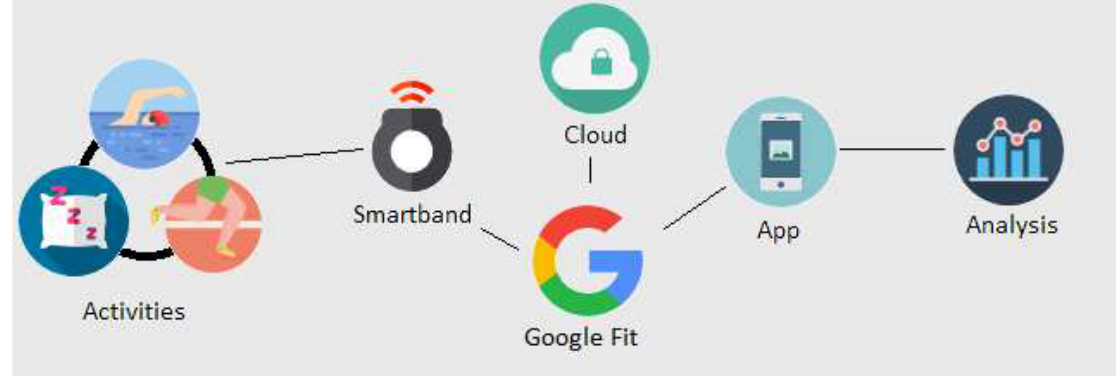
Figure 1. Overall